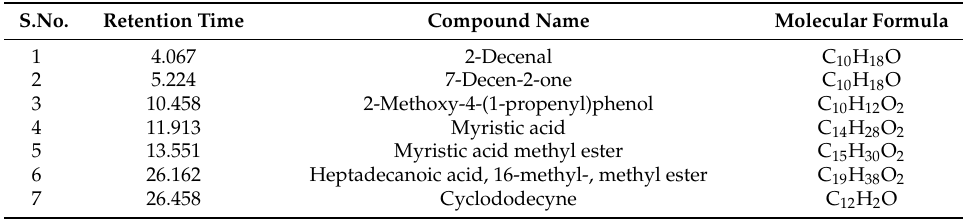
Table 2. GC-MS analysis of Cu nanoparticles of nutmeg.